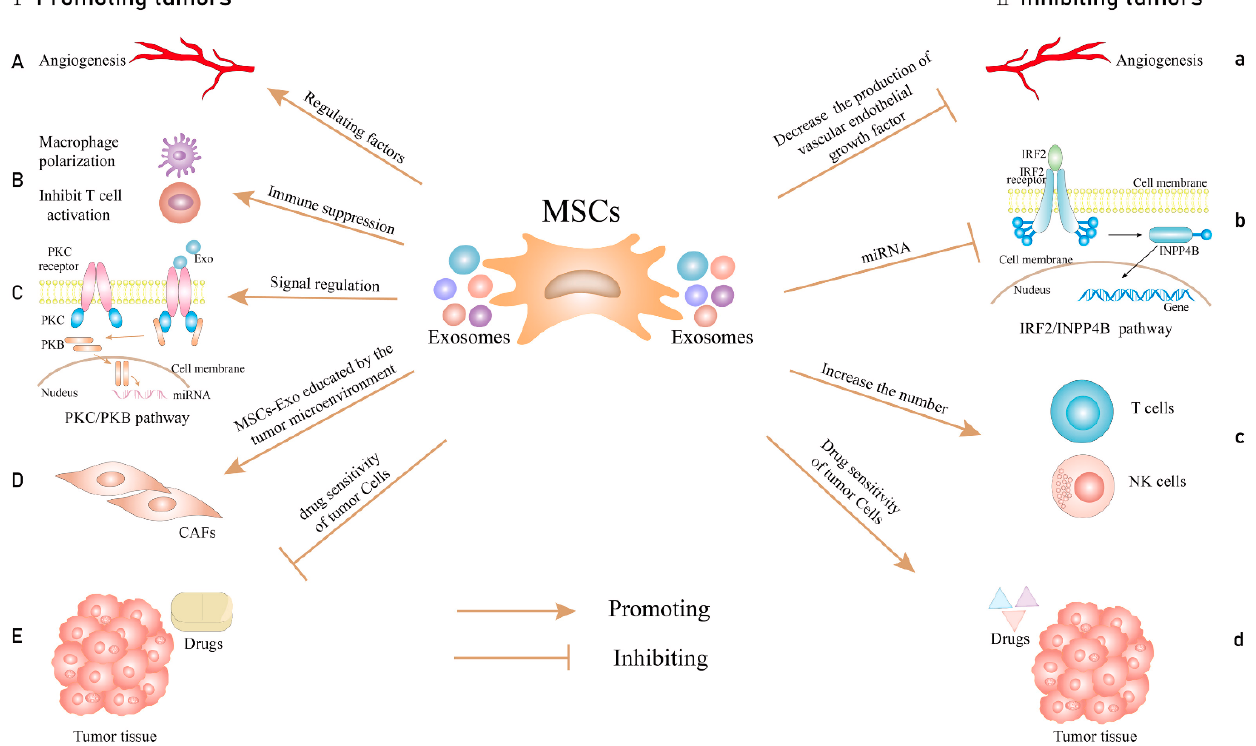
Figure 12. The influence of exosomes on tumor progression. Promoting tumors: ( A ) including the regulation of the secretion of mediators of angiogenesis; ( B ) promoting the immune escape by regulating macrophage polarization and inhibiting T cell activation; ( C ) stimulates tumor cell proliferation by affecting signaling pathways; ( D ) the tumor microenvironment mediates cancer-associated fibroblast (CAF) formation by educating MSCs-Exo; ( E ): MSCs-Exo increase drug resistance. Inhibiting tumors: ( a ) inhibition of angiogenesis; ( b ) inhibition of tumor proliferation through miRNA-mediated signaling pathways; ( c ) increase the number and sensitivity of T cells and NK cells; ( d ) improving drug sensitivity. Reprinted from an open-access source [145].